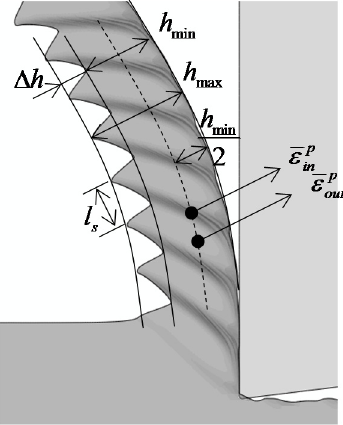
Figure 9. Geometric parameters for the assessment of chip morphology parameters.